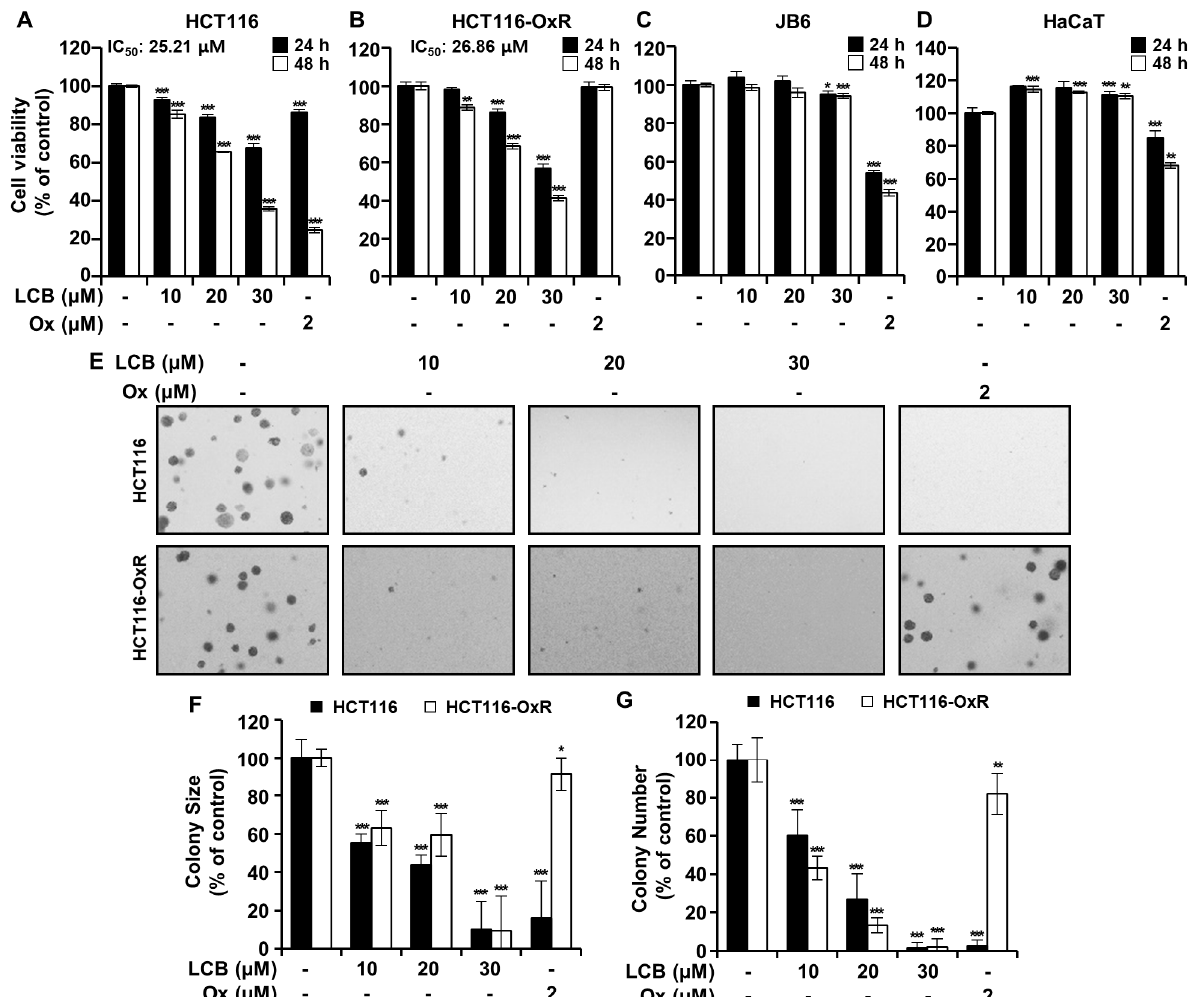
Figure 1. Licochalcone B (LCB) decreases cell viability and restricts the clonogenic properties of oxaliplatin (Ox)-sensitive or -resistant colorectal cancer (CRC) cell lines. HCT116 ( A ), HCT116-Ox-resistant (OxR) ( B ), JB6 ( C ), and HaCaT ( D ) cells were treated or not treated with different concentrations of Ox (2 µ M) or LCB (10, 20, and 30 µ M) for 24 h or 48 h. The MTT assay was used to reveal the cell viability of CRC cells at 24 h or 48 h after treatment with LCB at various concentrations. ( E ) The anchorage-independent growth ability of CRC cells was assessed using a soft agar assay. The cells were untreated or treated with the indicated concentrations of LCB or Ox and incubated for 7 to 10 days. Bar graphs indicate the colony size ( F ) and numbers ( G ). Colonies > 5 μ m were counted and measured. All data are represented as mean ± SD from triplicate experiments (* p < 0.05, ** p < 0.01, *** p < 0.001 versus the untreated group).